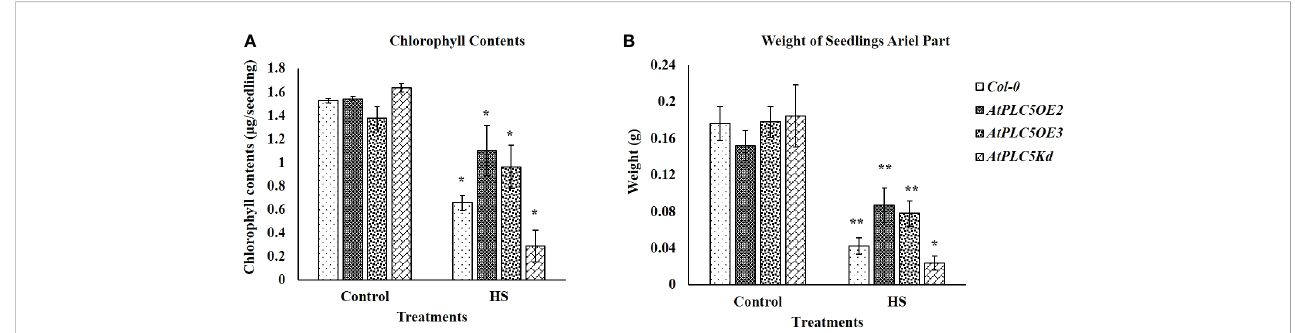
FIGURE 2 Fifteen days after acquired thermotolerance treatment (A) chlorophyll contents ( m g/seedling) and (B) weight (g) of the aerial part of seedlings were determined. Mean derived from 4 replicates, containing 34 seedlings for each genotype tested. Error bar represent standard deviation of the mean. Students t-test (*P < 0.05, **P < 0.01) was used to test the signi fi